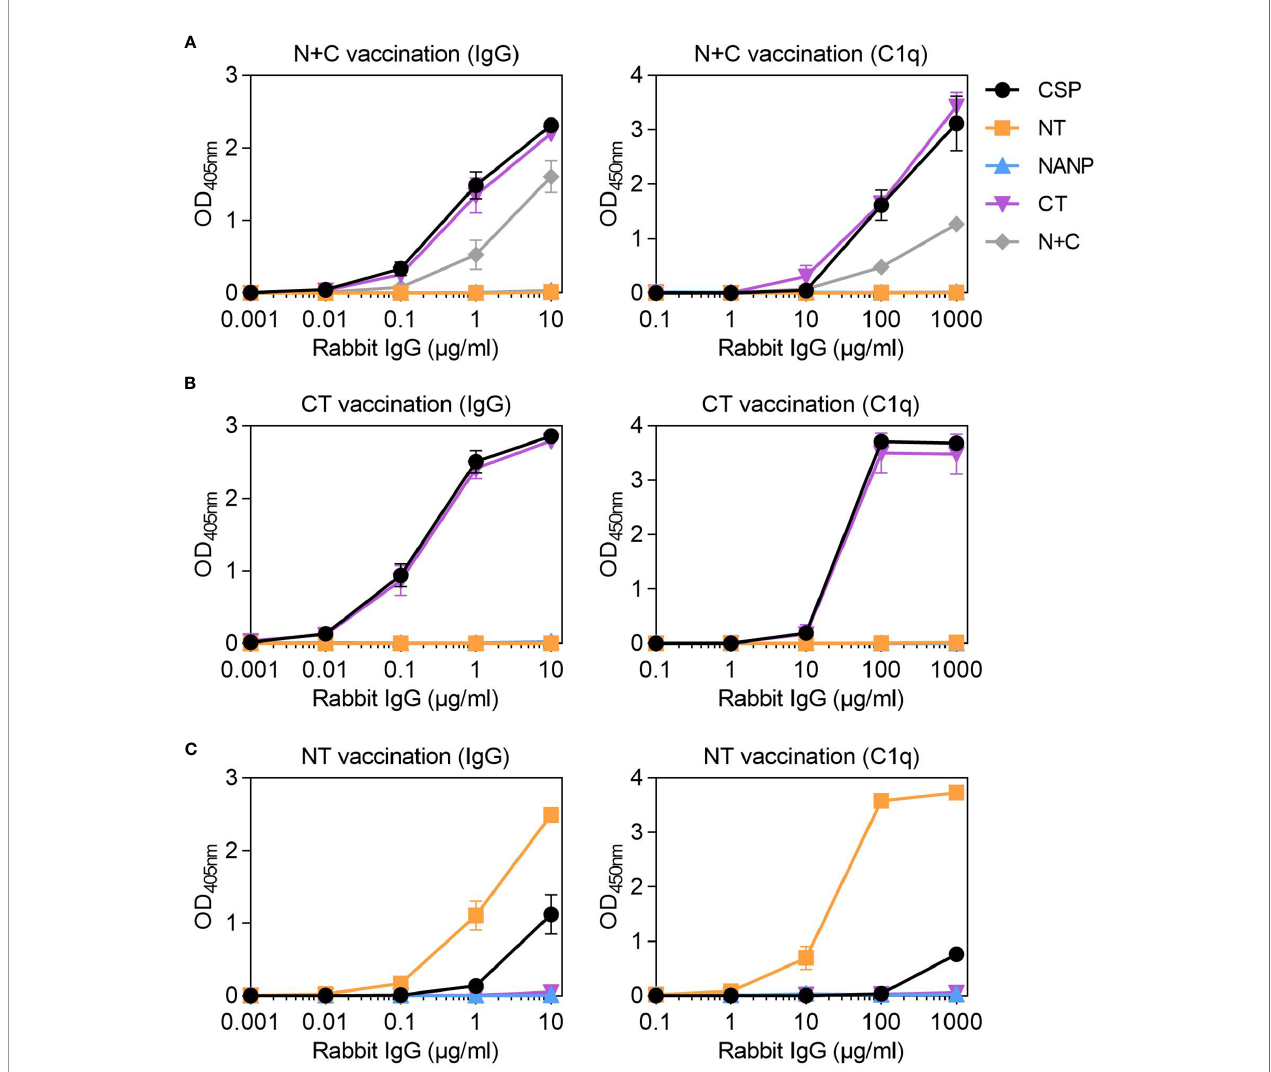
FIGURE 5 | Rabbit IgG to the non-repeat regions of CSP can fi x complement. Rabbit IgG were generated against (A) truncted CSP that lacked the central-repeat region (N+C) and the (B) C-terminal (CT) and (C) N-terminal (NT) regions of CSP. Rabbit IgG were tested for IgG at 0.001-10 m g/ml (left) and C1q- fi xation at 0.1- 1000 m g/ml (right) against full-length CSP, NT, NANP and CT anitgens [and N+C for panel (A) ]; x-axis was presented on a log10 scale. Results were corrected for background reactivity using no-IgG control wells and the mean and range of two independent experiments is